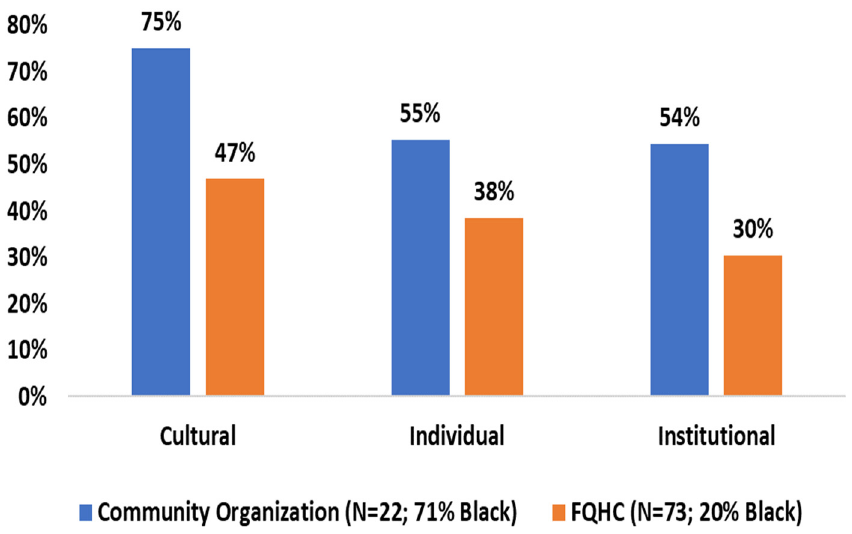
Figure 1. Self-reported race-related stress experiences ( N = 95).